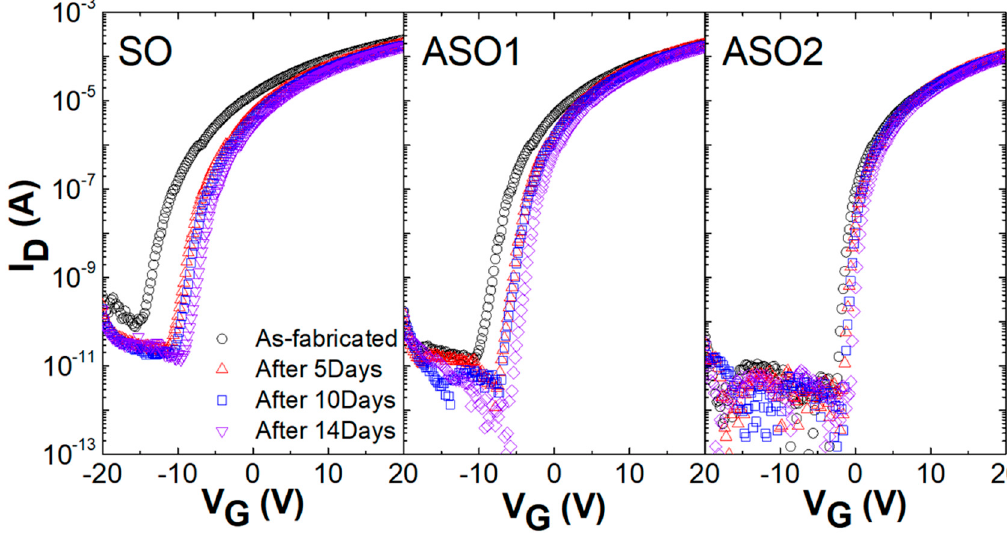
Figure 2. Changes in the transfer characteristics of SO, ASO1, and ASO2 TFTs (lacking passivation layers) over time.